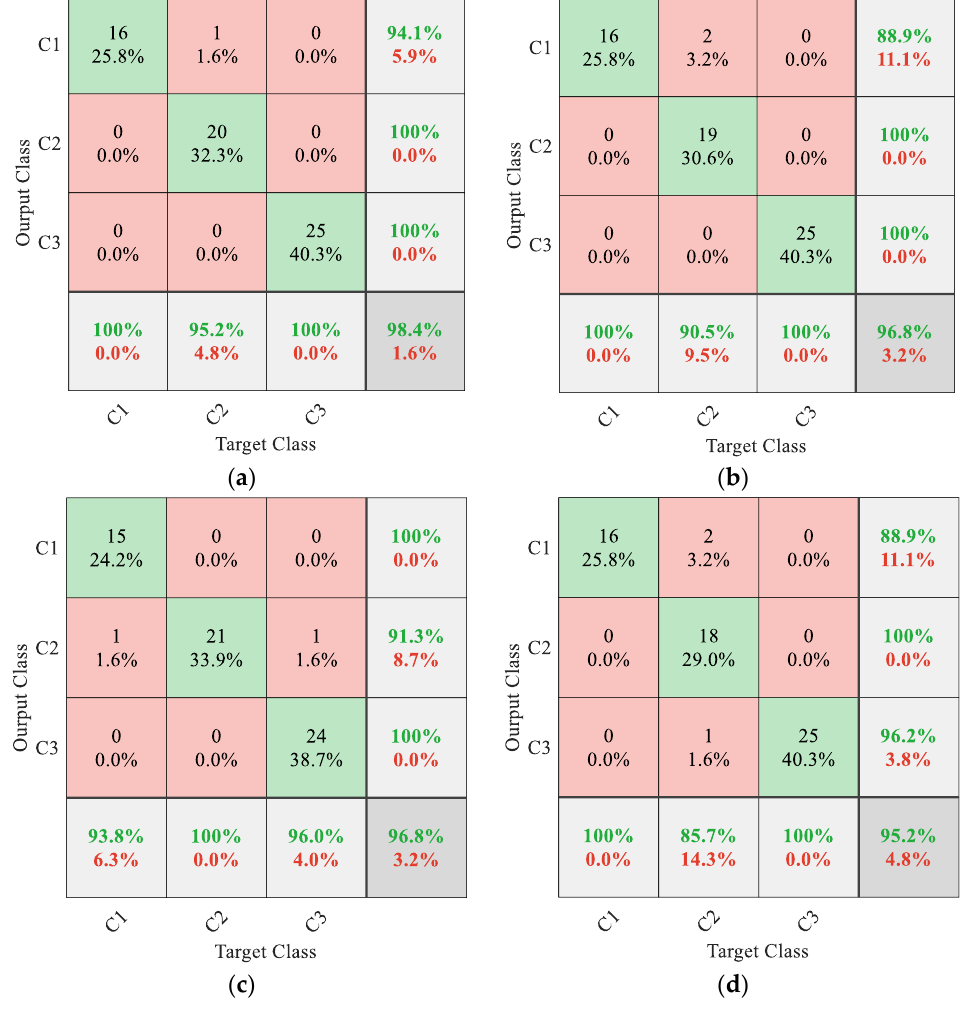
Figure 8. ( a ) MVMD – MMPE – 1D CNN tool wear conditions monitoring result. ( b ) MVMD – MMPE – GA-SVM tool wear conditions monitoring result. ( c ) MEMD – MMPE – 1D CNN tool wear conditions monitoring result. ( d ) MVMD – MPE – 1D CNN tool wear conditions monitoring result. Table 3. The average classification accuracy by different